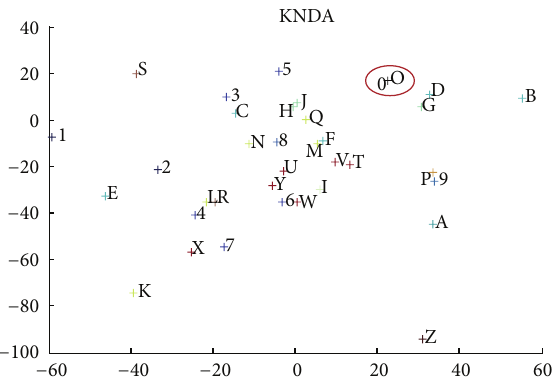
Figure 5: Subset of digit “9” and character “A” in the Binary Alphadigits database.